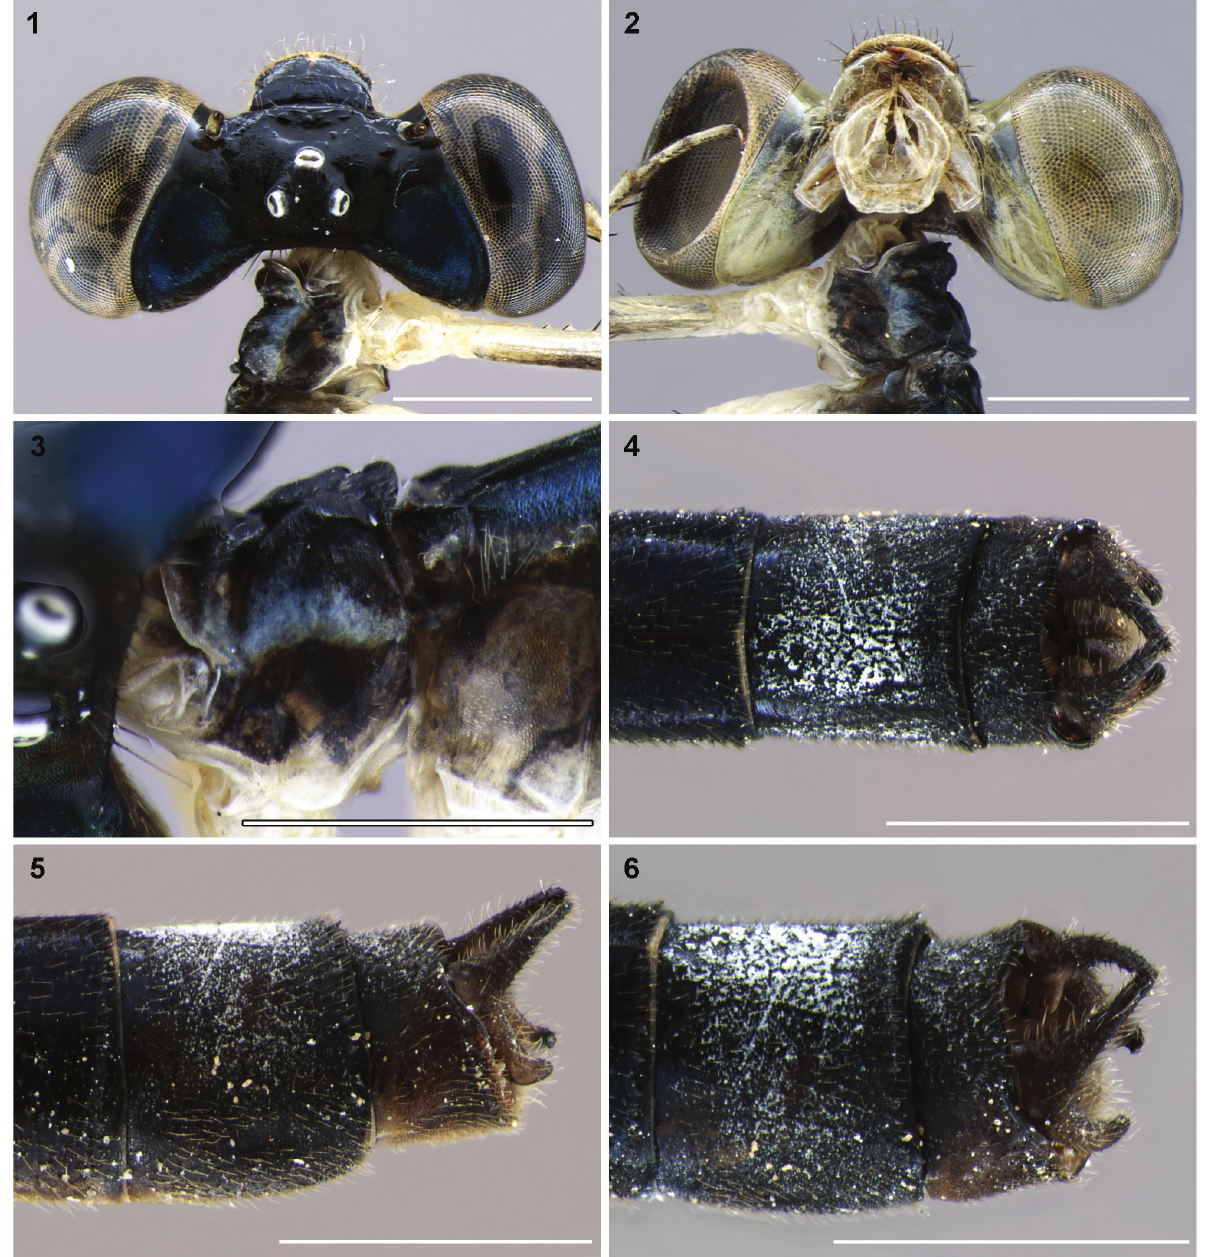
Figures 1–6. Forcepsioneura regua sp. nov., holotype male (Brazil. RJ: Cachoeiras de Macacu, DZRJ 2071): (1–2) head in dorsal (1) and ventral (2) views; (3) prothorax in lateral view; (4–6) caudal appendages in dorsal (4), lateral (5) and dorsolateral (6) views. Scale bars = 1 mm.